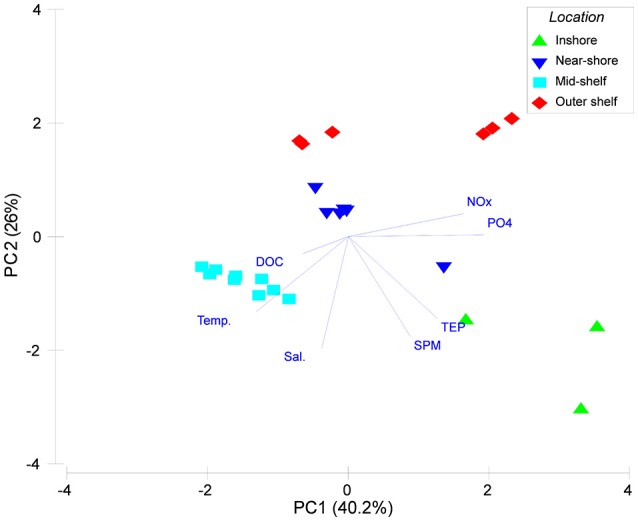
Principal component (PC) analysis of environmental and water quality parameters for the islands included in the cross-shelf gradient. Green triangles show samples from the inshore site, blue inverted triangles samples from the inshore area, turquoise squares mid-shelf sites, and red diamonds indicate samples from the outer shelf sampling stations.